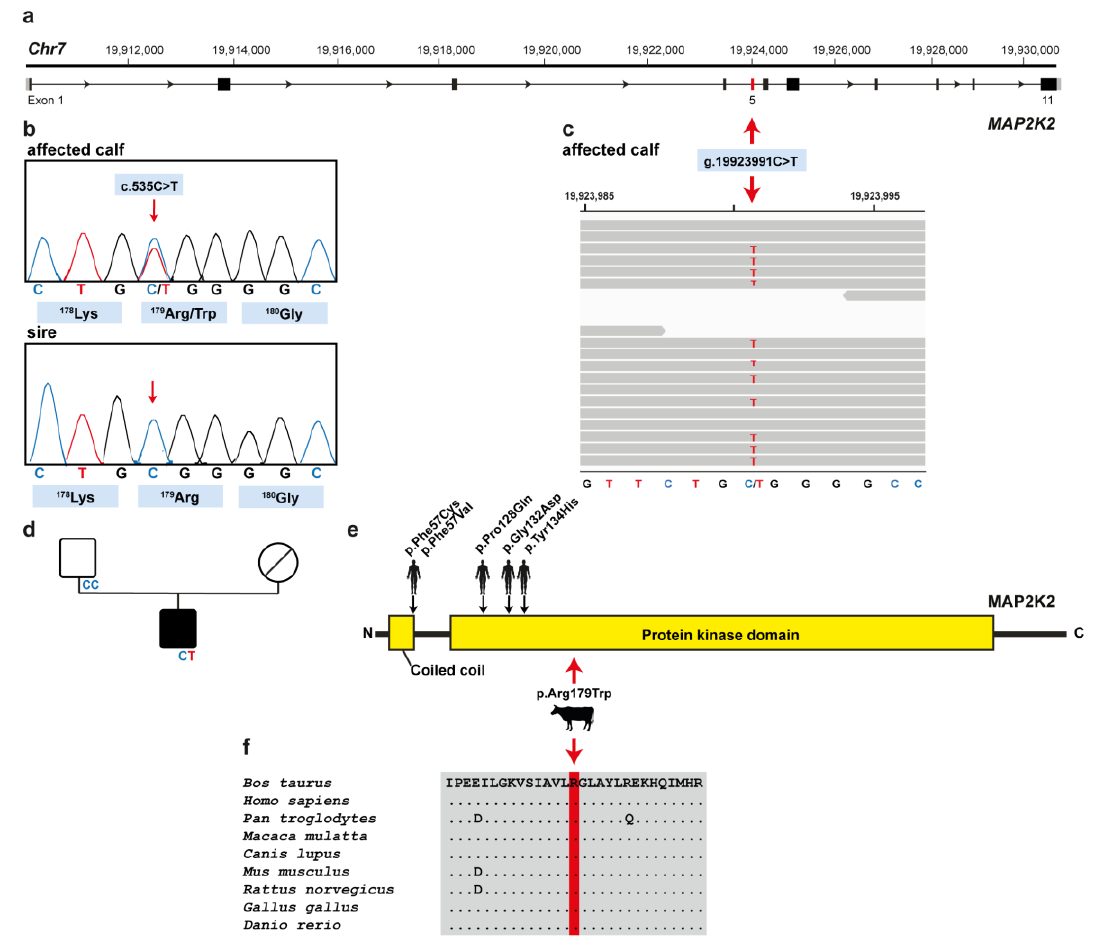
Figure 3. MAP2K2 missense variant in a Romagnola calf with skeletal-cardio-enteric dysplasia: ( a ) MAP2K2 gene structure representation of the exact position of the exon 5 variant on the chromosome 7 (red arrow); ( b ) Electropherograms confirming heterozygosity in the affected calf and the absence of the variant in the germline of the sire. ( c ) IGV screenshot presenting the Chr7: g.19923991C>T variant in the calf. ( d ) Pedigree of the case. The affected male calf is represented with full black symbol, while both non-affected parents are represented by full white symbols. Unknown genotype is repre- sented by a symbol with a diagonal line. ( e ) Schematic representation of MAP2K2 protein and its functional domains and summary of known human MAP2K2 mutations. The position of the mutation detected in the affected Romagnola calf is indicated by a red arrow, while know human MAP2K2 mutations associated with cardio-facio-cutaneous syndrome are indicated by black arrows (OMIM601263). ( f ) Multiple sequence alignment of the protein kinase domain of the MAP2K2 protein around the position of the p.Arg179Trp variant shows complete evolutionary conservation across all species. 4. Discussion Non-infectious syndromic congenital malformations of newborns in cattle occur rarely and are most often not further diagnosed in detail. We have carried out a compre- hensive pathological and genetic examination in a Romagnola stillborn calf, revealing a skeletal-cardio-enteric dysplasia. We then investigated the hypothesis of a spontaneous mutation as a possible reason for this congenital phenotype. Using state-of-the-art genetic approaches involving WGS, geneticist have only about a 50:50 chance of quickly identify- ing variants that are causal for developmental anomalies in humans [18]. So far, similar data is missing for veterinary medicine, mostly due to the lack of resources, although the scientific value for biomedical research is widely accepted [4]. Analysis of the genome sequence of the studied case identified a missense variant in a plausible candidate gene affecting the protein kinase domain of MAP2K2 . In addition, this variant was only present in the genome of the affected calf, and did not occur in a global control cohort of more